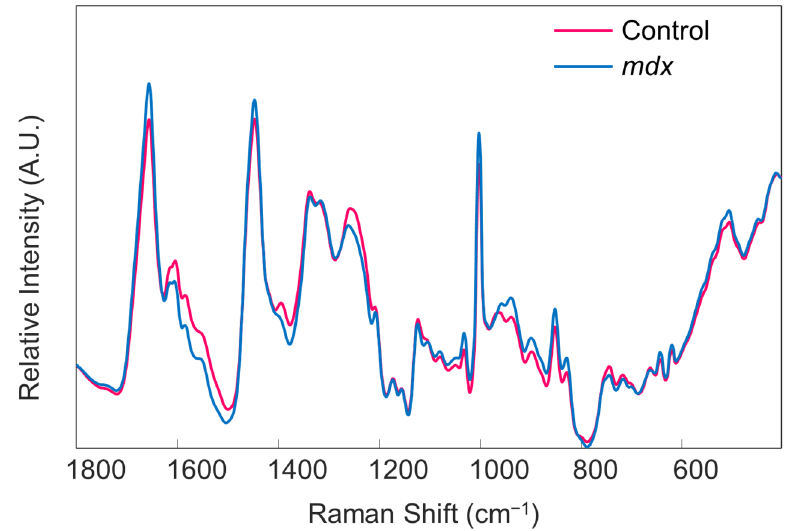
Figure 5. The mean preprocessed Raman spectra of all blood serum samples obtained from the control (pink trace) and mdx model mice (blue trace), before mean centering. Reprinted with permission from N. M. Ralbovsky, P. Dey, A. Galfano, B. K. Dey, and I. K. Lednev, Diagnosis of a model of Duchenne muscular dystrophy in blood serum of mdx mice using Raman hyperspectroscopy, Scientific Reports, 10, 11734, Copyright (2020) Springer Nature.